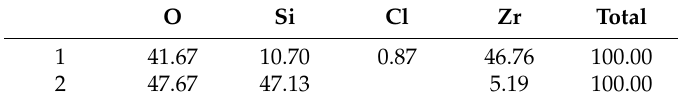
Table 1. The relative content of elements in both points of SiO 2 ZrO 2 films. Units = wt.%. O Si Cl Zr